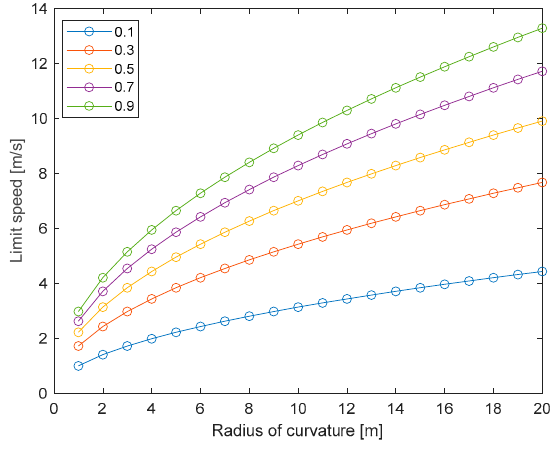
Figure 28. Lateral slipping limit speed.